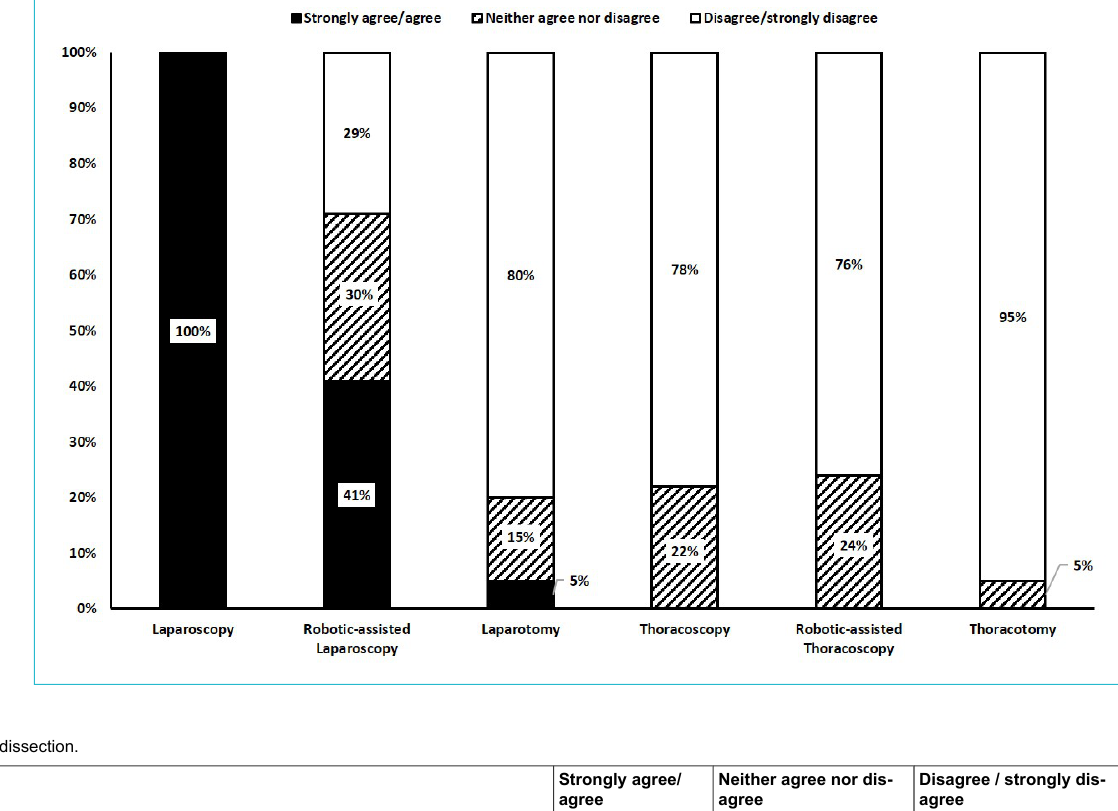
Figure 1: Surgical access routes in type III hiatal hernia repair (% of agreement).